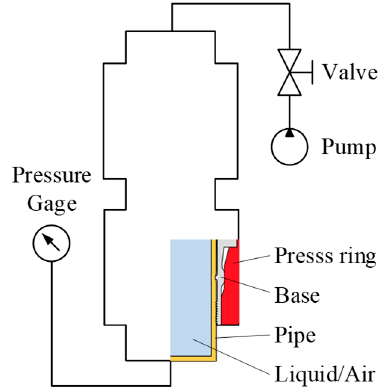
Figure 19. Schematic diagram of the experimental setup.